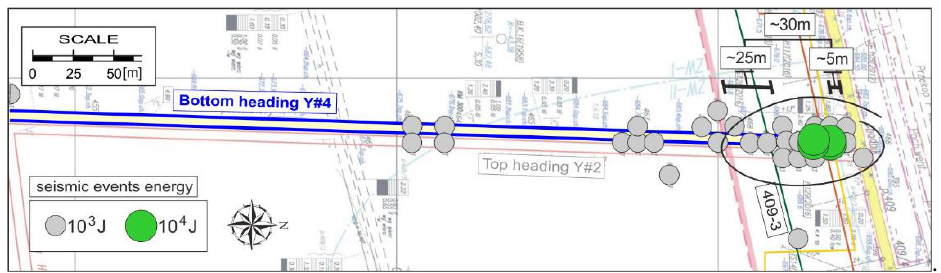
Figure 6. Distribution of seismic events with energy E ≥ 10 3 J during the drifting of bottom heading Y#4. Bottom heading Y#2. The analysis of rock strata seismic activity in conjunction